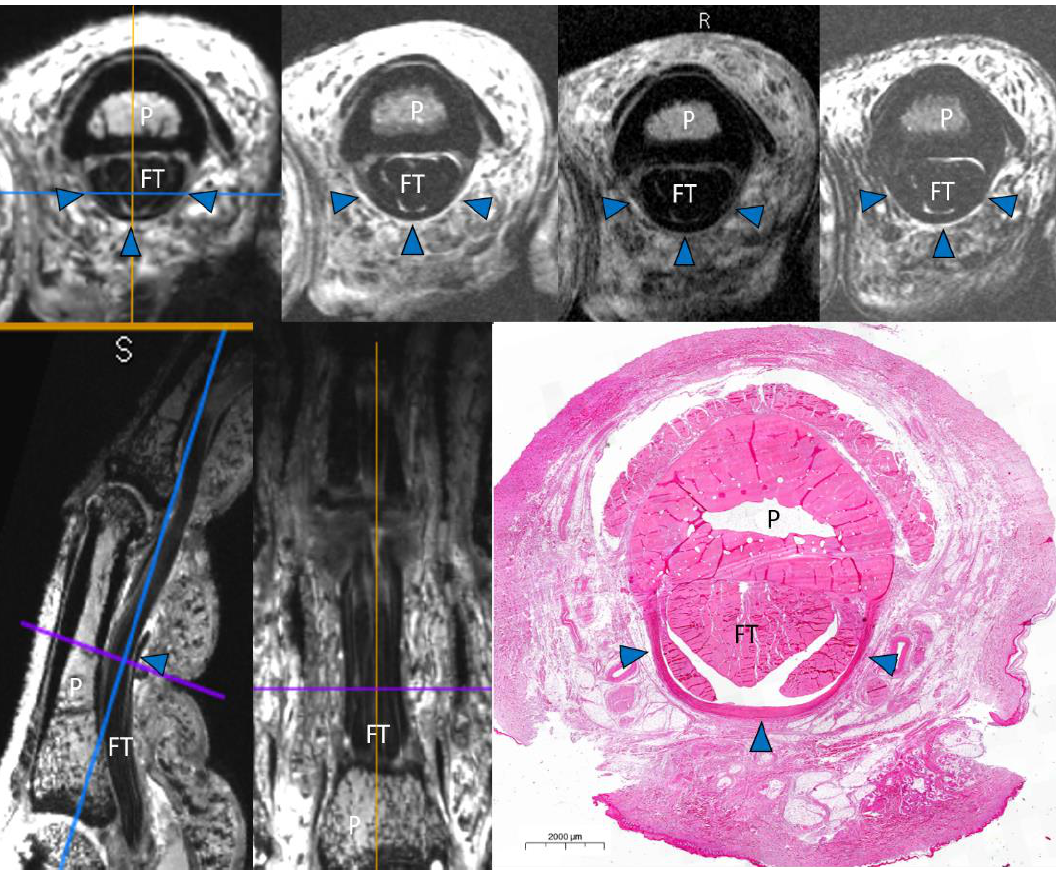
Figure 1. Example of the study protocol with an intact A2 pulley. Three-dimensional double echo steady-state (3D DESS) axial multiplanar reconstruction (MPR), axial PD fs, T1 turbo spin echo (TSE), and T2 TSE scans ( above ). 3D DESS sagittal and coronal MPR. Histological correlation ( below ). P = phalanx. FT = flexor tendon. Arrowheads = intact A2 pulley.